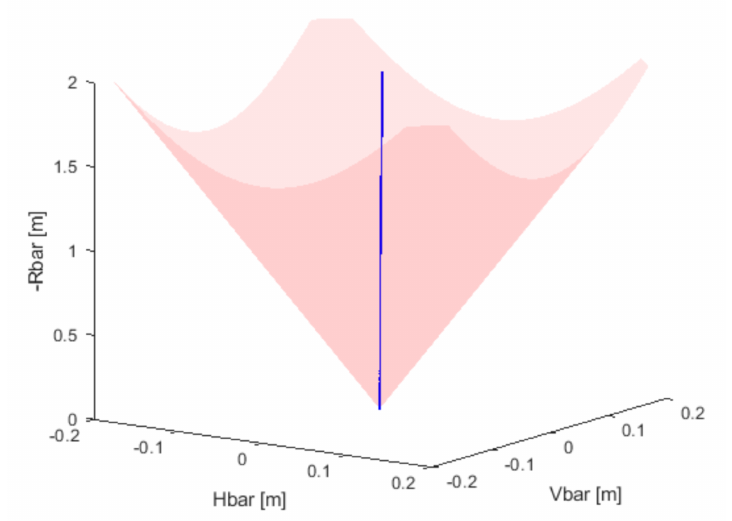
Figure 8. Focus on the 3D relative trajectory in the last 2 m with the cylinder